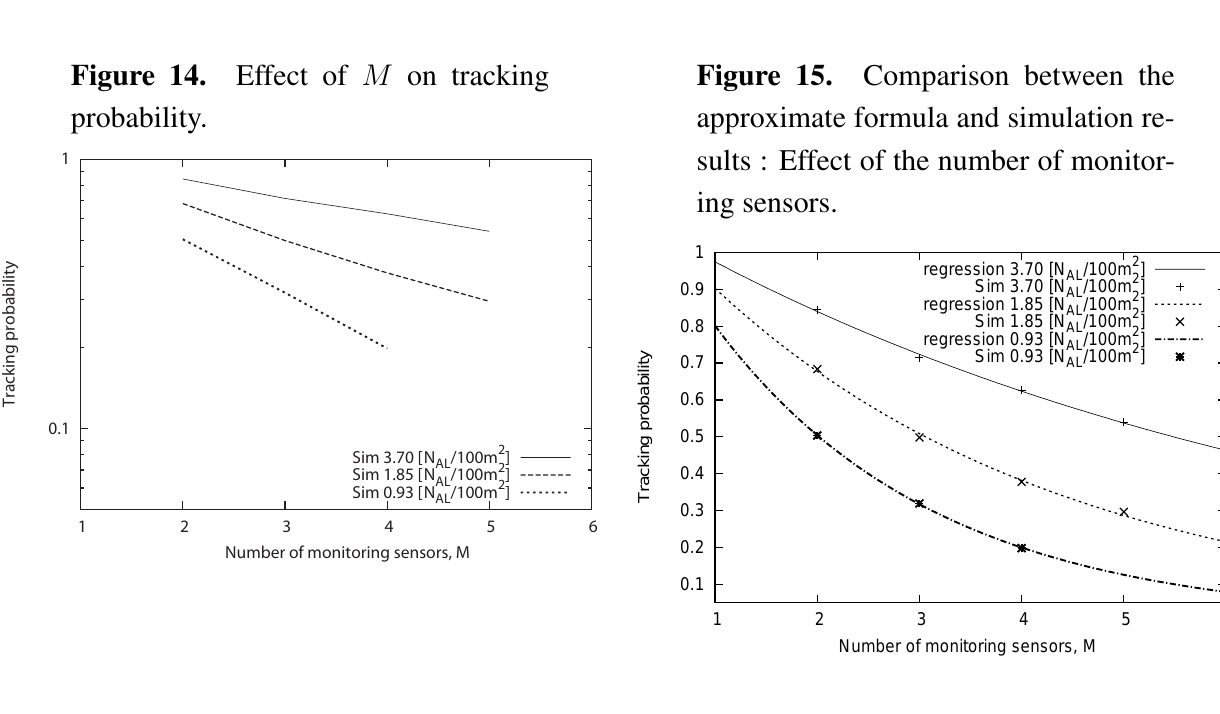
Figure 15. Comparison between the approximate formula and simulation re- sults : Effect of the number of monitor- ing